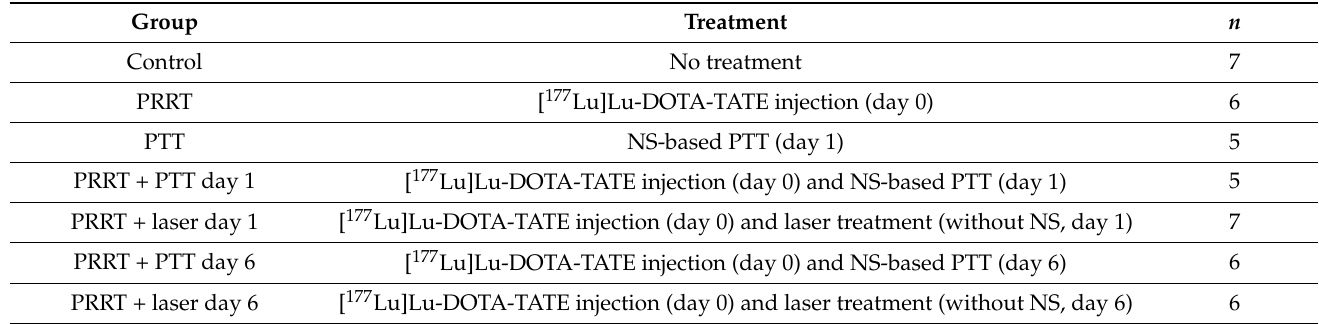
Table 1. Experimental treatment groups. Mice were divided into seven groups, receiving different treatments. For PRRT, all animals were administered ~20 MBq of [ 177 Lu]Lu-DOTA-TATE on day 0. For PTT, all animals were injected with NS 24 h prior to laser irradiation (day 1 or day 6). PTT control animals (laser groups) were irradiated without previously receiving